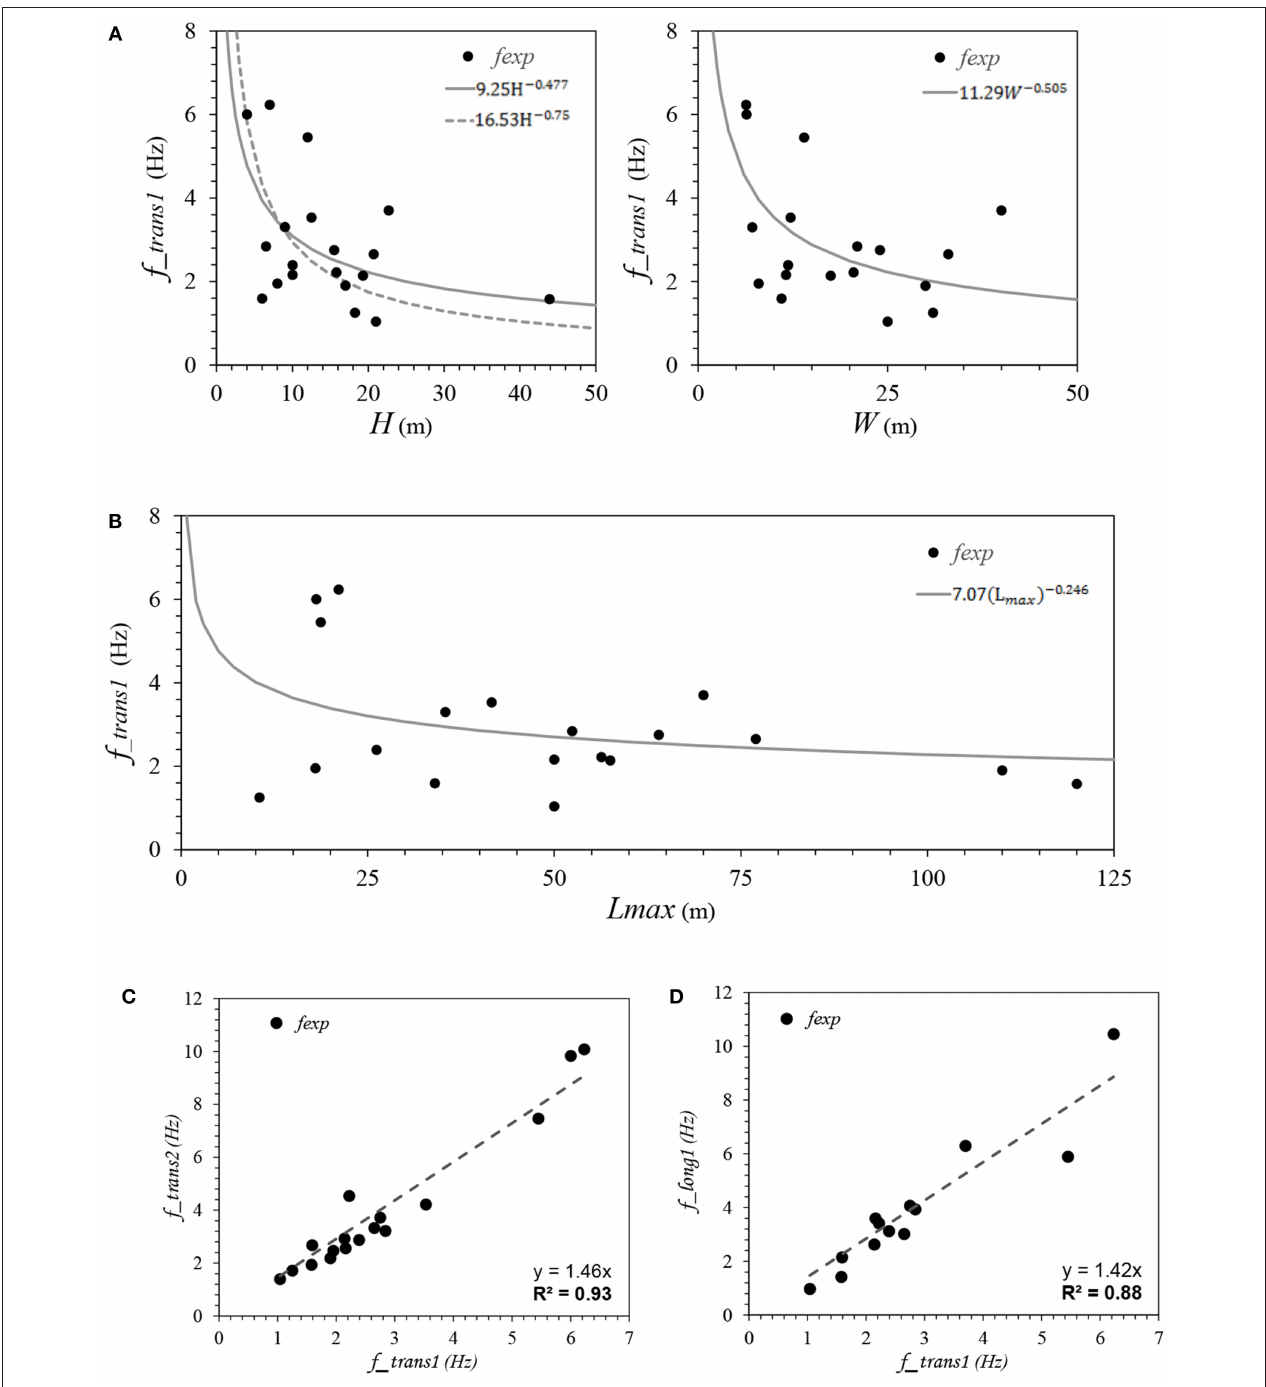
FIGURE 9 | Performances of the three proposed equations for the first natural frequency f_trans1 with the one-variable formulas (A,B) , and correlation between the first main frequency in the transversal direction and the others one: (C) f_trans1 vs. f_trans2 and (D) f_trans1 vs. f_long1 . As for the two-variable models ( Table 5 ), the considered L max (such as the formulas 1, 5, and 7) provide the lowest matching with the experimental data. On the parameters are, again, H , W , L max and the further other hand, the models including the parameter E , either Young’s modulus E . It is easy to note that the proposed considering the height H ( Formula 3 ) or W ( Formula 6 ) formulations considering the parameter length in plan